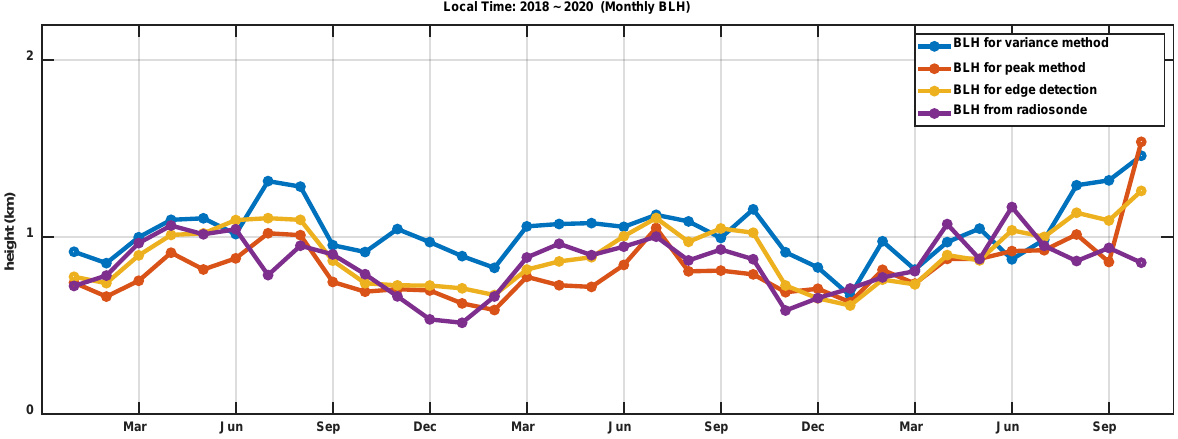
Figure 8. Monthly BLHs retrieved using the variance, peak, and ED methods and the RS measurements.